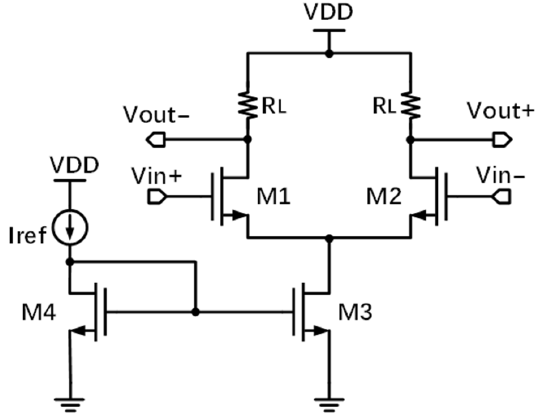
Figure 11. Schematic of CML LED driver.